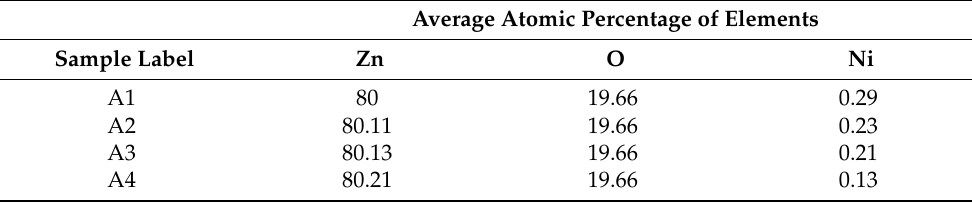
Figure 5. SEM micrographs of samples A1 ( a – c ), A2 ( d – f ), A3 ( g – i ), and A4 ( j – l ) are arranged in columns. In each micrograph set the image at the top corresponds to a larger area, a magnification of a particular structure is presented in the middle, and an elemental composition analysis (EDS) is at the bottom of each column. Table 3. Average of the atomic percentage of the elemental composition of the samples. The atomic percentage of Ni decreases as the deposit temperature